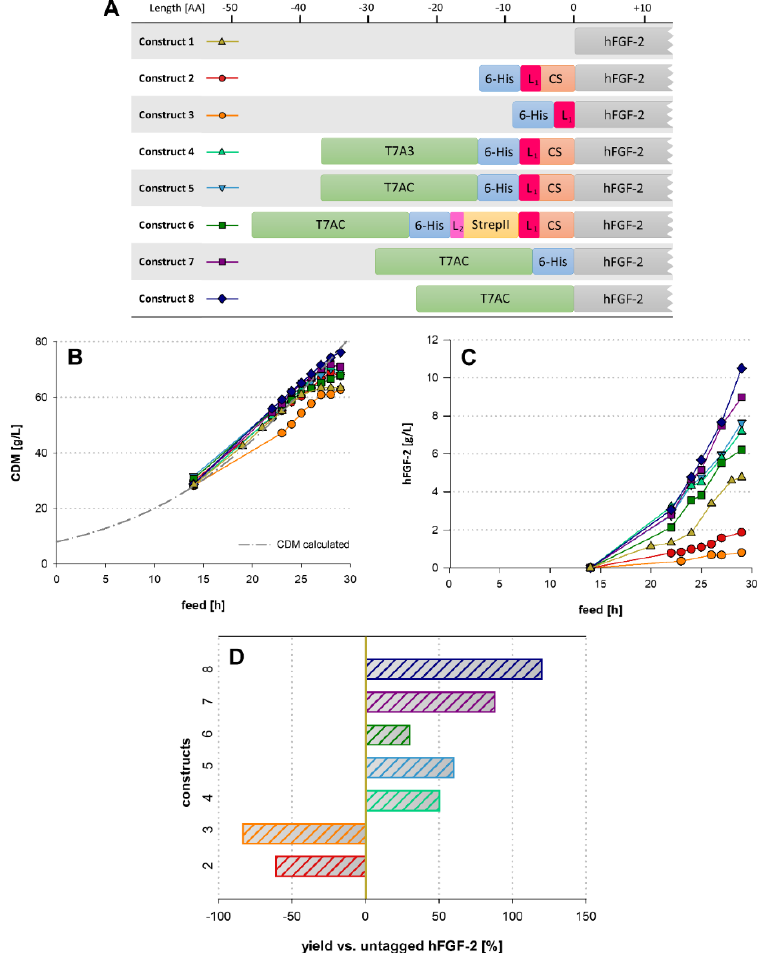
Figure 1. Panel ( A ): Schematic representation of all hFGF-2 constructs and tag variations; L stands for linker while CS denotes the caspase-2 cleavage site; the number of amino acids in the tag constructs is displayed by the ruler above; complete sequences of all tag elements are listed in Supplementary Materials Table S1. Panel ( B ): cell growth in the course of time. Panel ( C ): Volumetric soluble protein titer throughout the fermentation process of the tag constructs. Panel ( D ): Ratio of stoichiometric POI yields at the end of the fermentations. The 0% line represents the titer of untagged hFGF-2. All values represent stoichiometric POI yields.